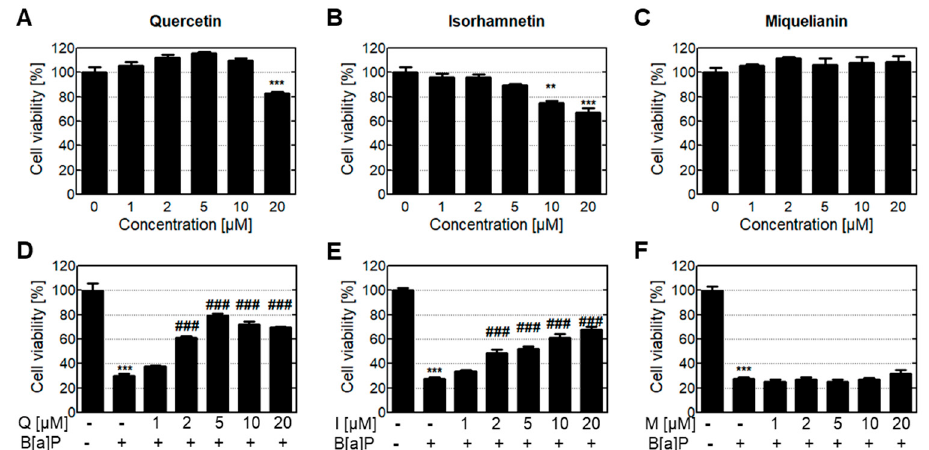
Figure 1. Cytotoxic effect of quercetin and its metabolites on HepG2 cells treated with or without B[a]P. The cytotoxicity of the compounds ( A ) quercetin, ( B ) isorhamnetin, and ( C ) miquelianin was determined. Then, the protective effect of each compound against B[a]P was evaluated. Cells were treated with a combination of 10 µ M B[a]P and ( D ) quercetin, ( E ) isorhamnetin, or ( F ) miquelianin. ** p < 0.01, *** p < 0.001 in comparison with untreated cells; ### p < 0.001 in comparison with B[a]P-treated cells.